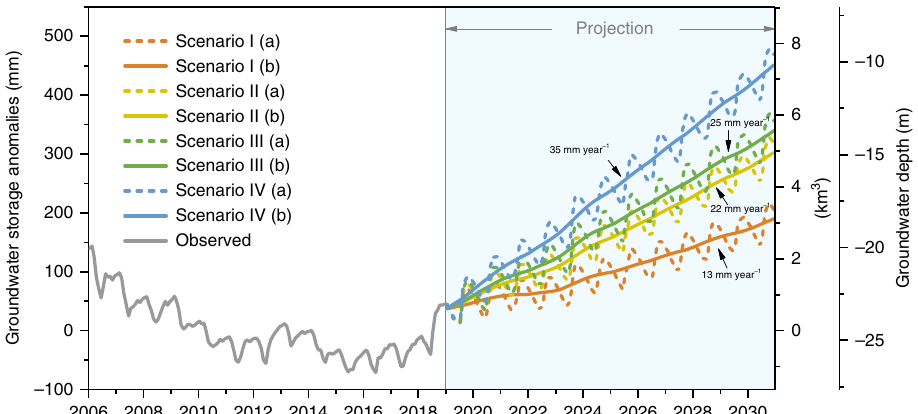
Fig. 6 GW level projection under precipitation and GW use scenarios. The observed GWS anomalies are relative to the mean during 2006 ‒ 2018 and their decomposed time series (2019 ‒ 2030) under four scenarios. Scenario I: normal GW use (G1) + precipitation climatology (P1); Scenario II: low GW use (G2) + P1; Scenario III: G1 + a wet climate (P2); and Scenario IV: G2 + P2. Solid lines are observed or simulated GWS anomalies, and dashed lines are corresponding decomposed time series (see the “ Methods